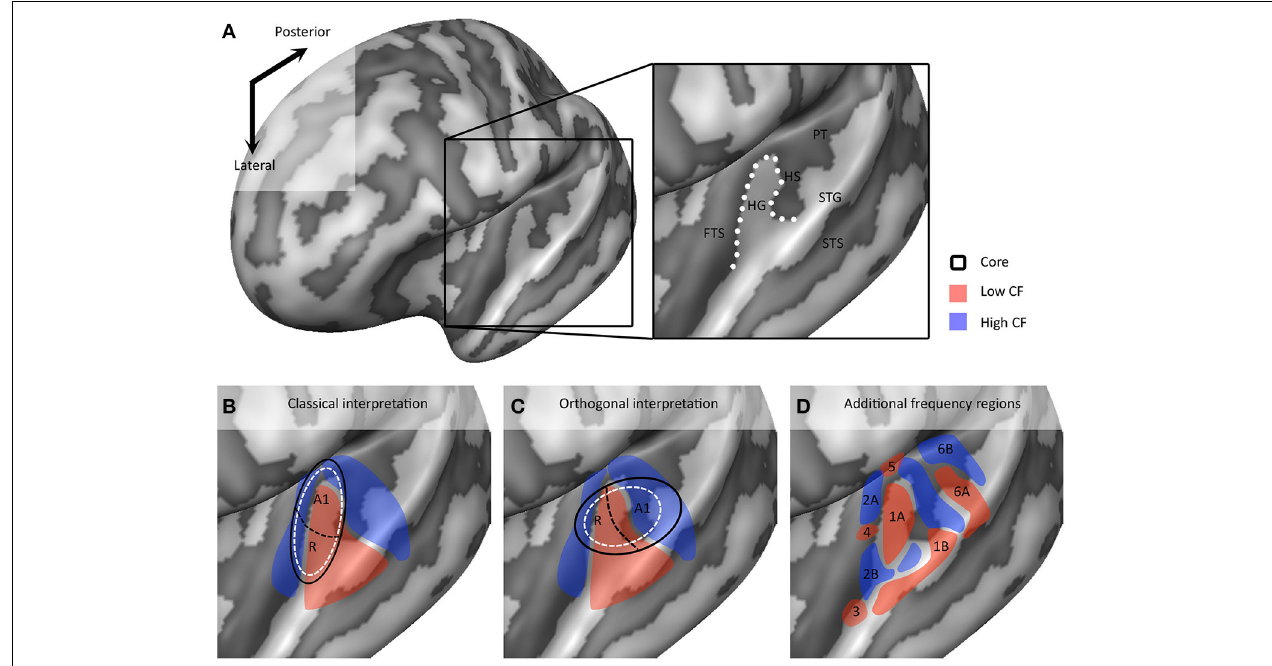
FIGURE 3 | Interpretations of tonotopic maps. (A) Inflated representation of the left hemisphere. Light and dark colors reflect gyri and sulci, respectively. The black square outlines the part of cortex highlighted in the rest of the figure. The macro-anatomy of the auditory cortex is displayed on the right, showing Heschl’s gyrus (HG), first transverse sulcus (FTS), Heschl’s sulcus (HS), planum temporale (PT), superior temporal gyrus (STG), and